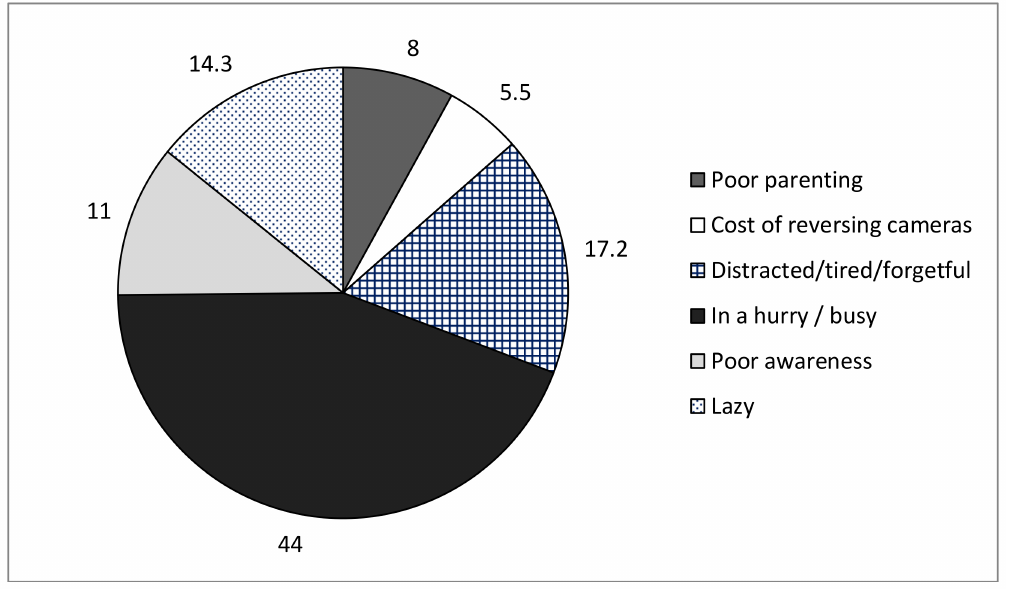
Figure 1. Reasons that others do not use safe strategies in the driveway